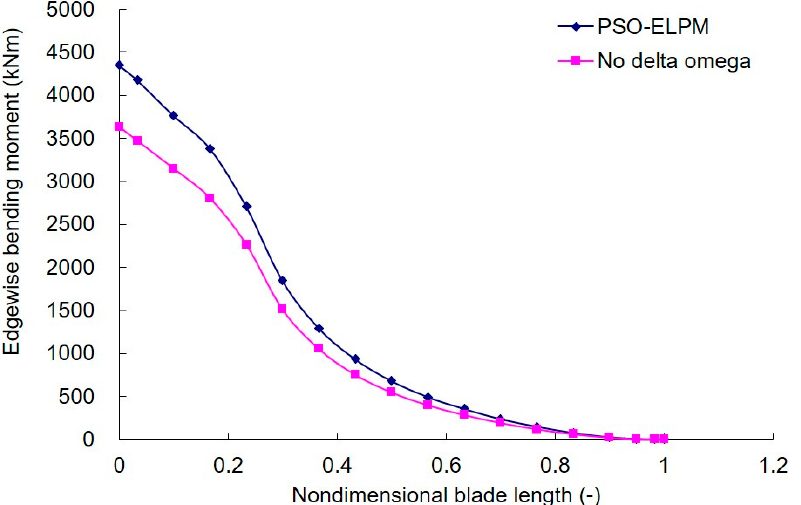
Figure 16. Comparison of extreme flapwise bending moment along the blade (2.0 MW).